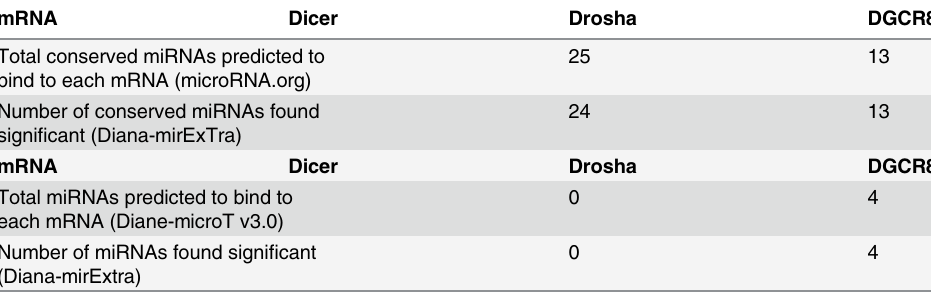
25 13 24 13 0 4 0 4